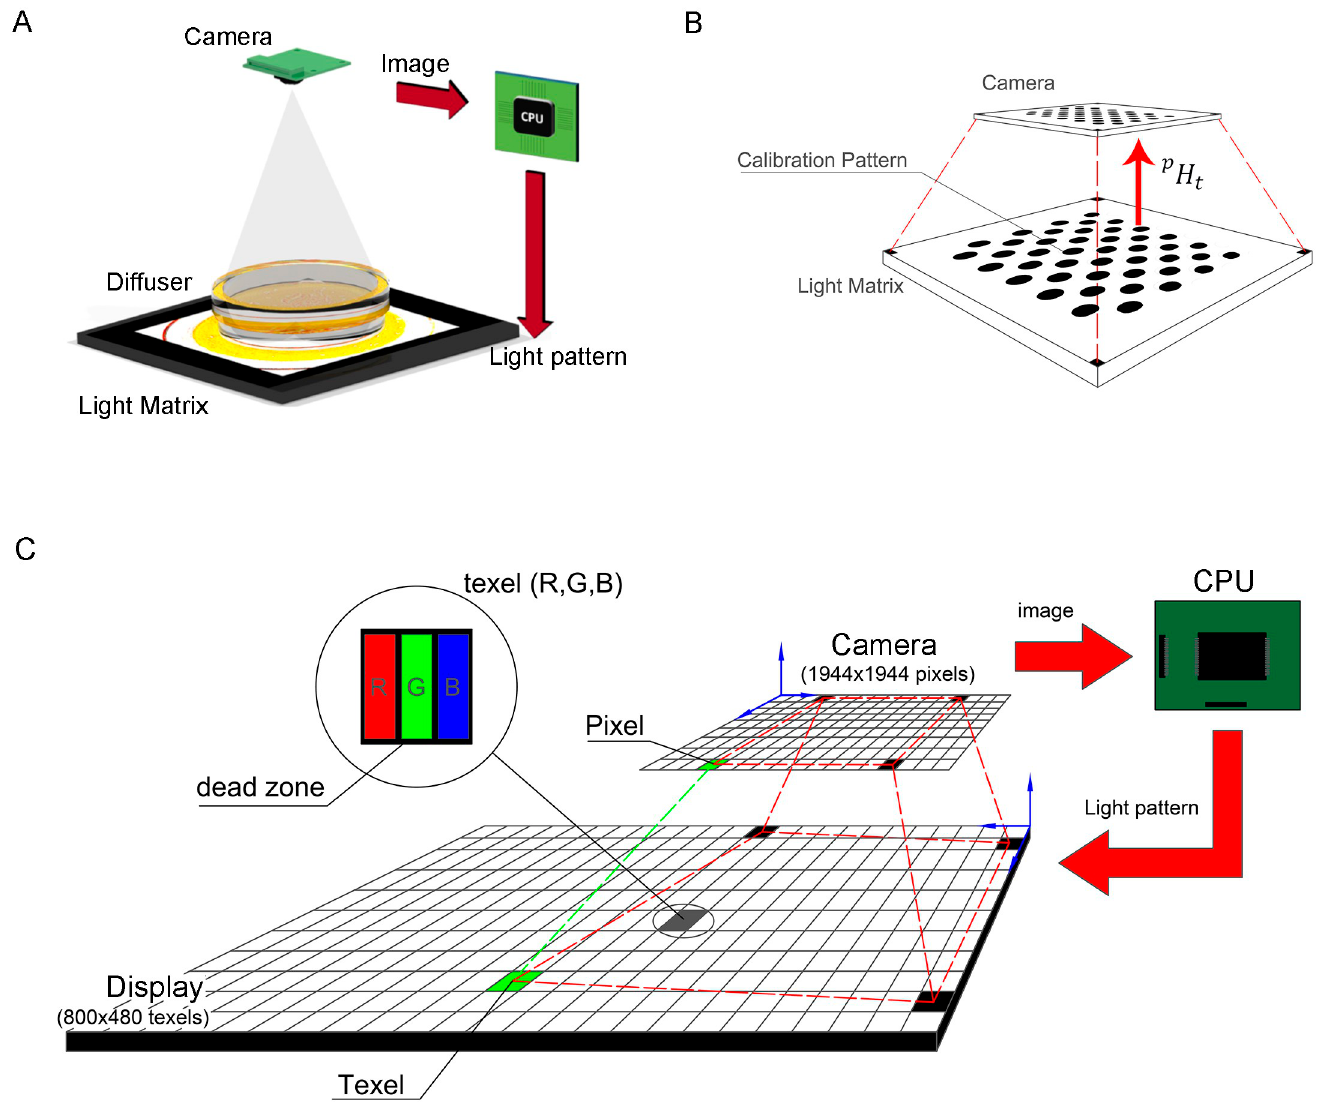
Fig 1. Physical configuration. A: Backlight scheme. B: Homography calibration scenario. C: Physical features of some components.